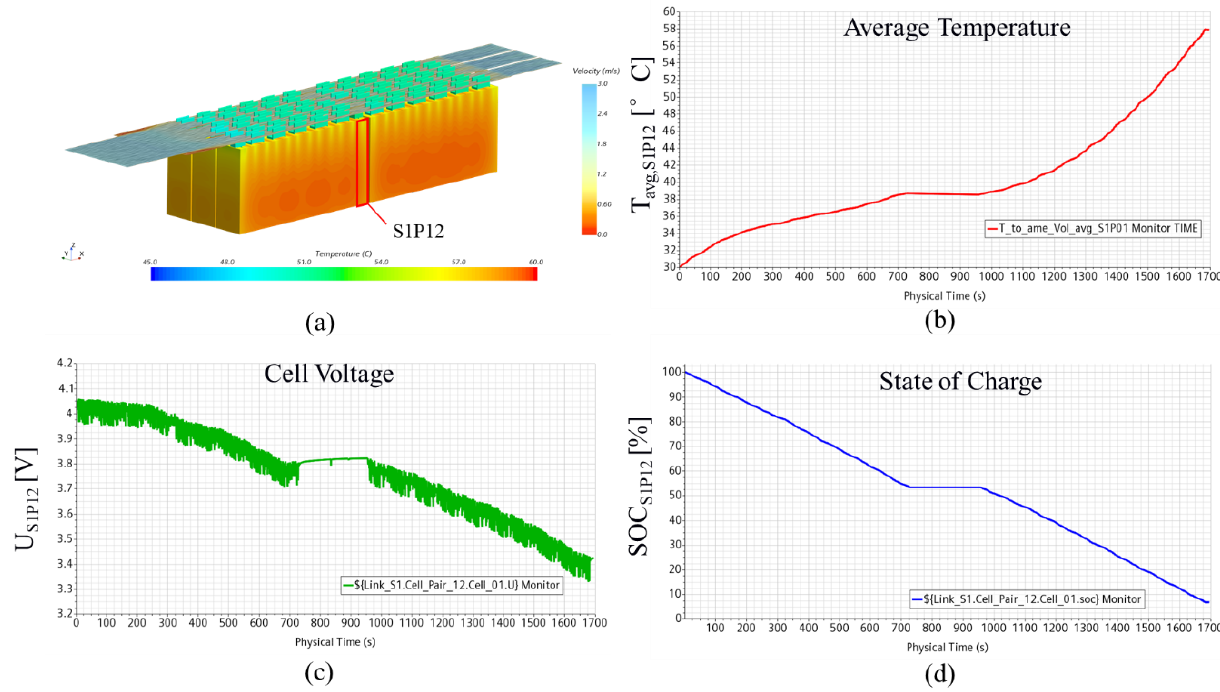
Figure 9. Velocity field of air region ( a ); cell pair temperature ( b ), SoC ( c ) and voltage ( d ) over time for one selected cell pair.